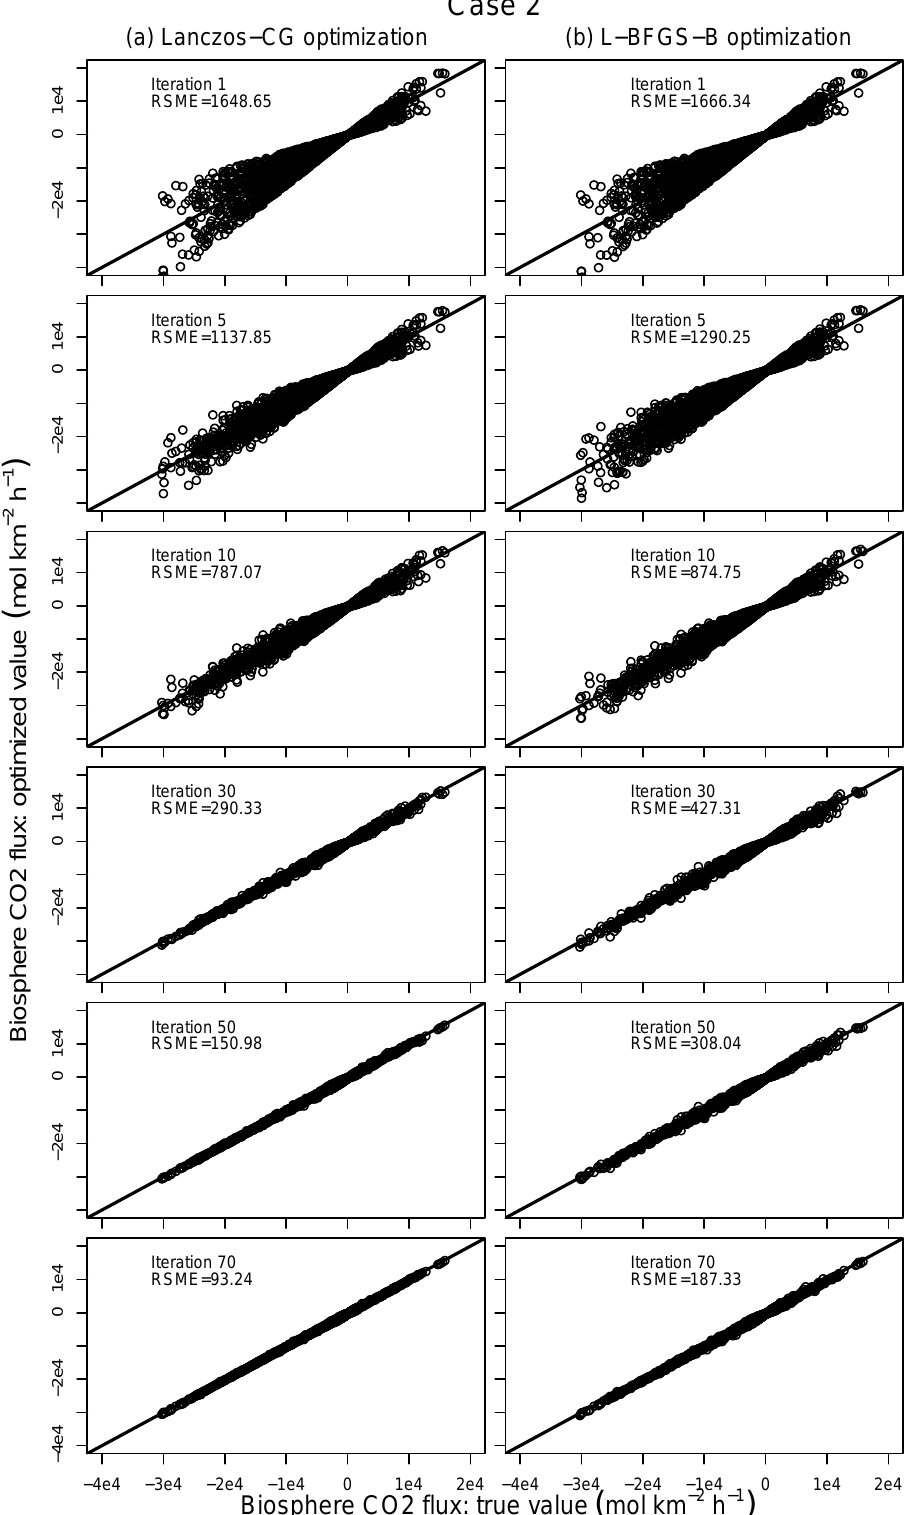
Figure 16. Same as Fig. 14 but for the inverse modeling experiment (Case